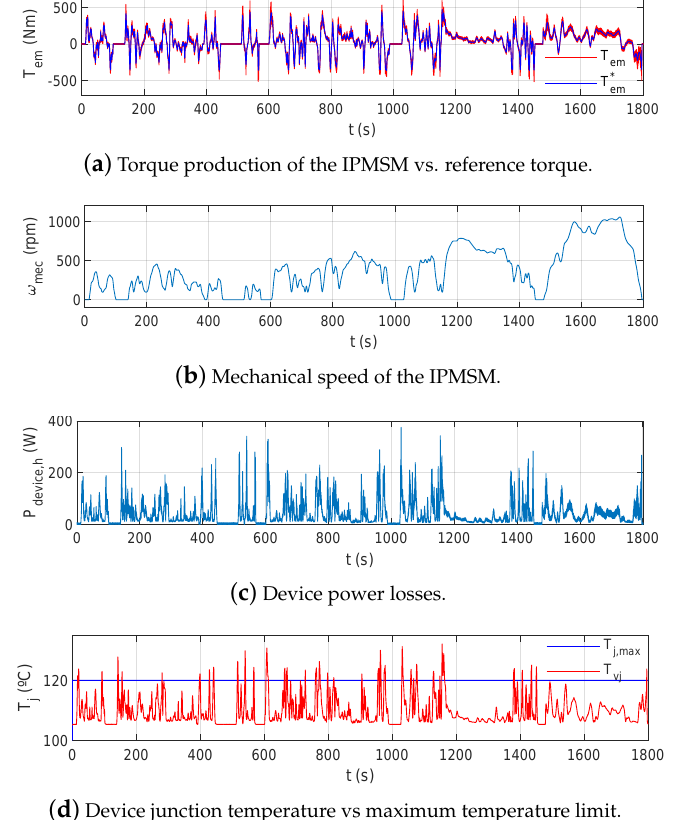
( d ) Device junction temperature vs maximum temperature limit. Figure 8. Simulation results of the SiC based IPMSM drive under standardized World Harmonized Light-duty Vehicle Test Procedure (WLTP) driving cycle without TCT